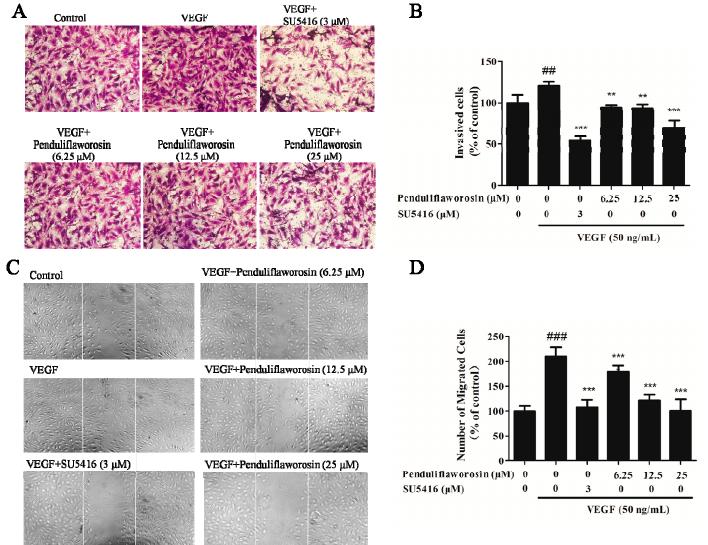
Figure 2. Penduliflaworosin suppressed VEGF-induced invasion and migration of HUVECs. The ( A ) invasion and ( C ) migration of HUVECs were photographed. The numbers of ( B ) invading and ( D ) migrating cells were counted after treatment with compounds (penduliflaworosin or SU5416) at different concentrations. Cells treated with medium only were used as the vehicle control. Data are shown as the percentage of the vehicle-treated control. Values are represented as the mean ± standard deviation ( n = 3). Mean values showing significant differences between the control group and the VEGF-treated group are denoted by ## ( p < 0.05) or ### ( p < 0.001). Mean values showing significant differences between the VEGF-treated group and the penduliflaworosin-treated group are indicated by ** ( p < 0.01), or *** ( p < 0.001).